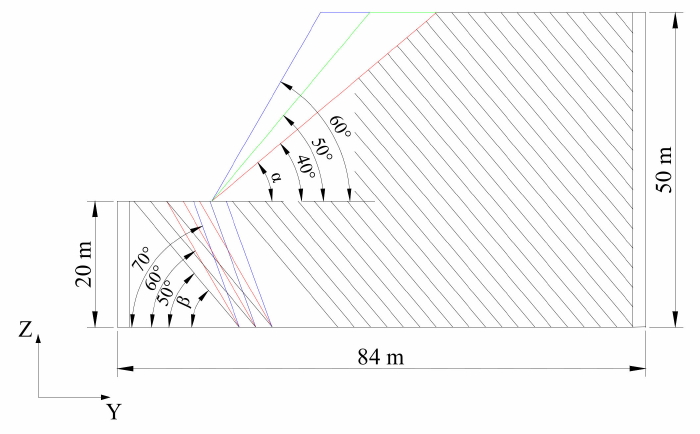
Figure 1. Side view of the discrete-element model of the slope.